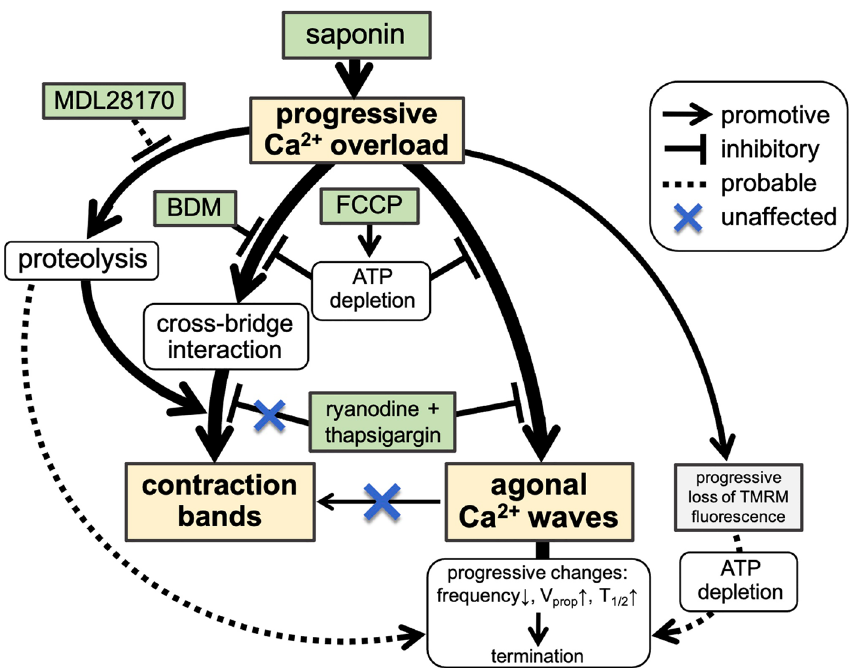
Figure 8. Schematic presentation of the saponin-induced generation of Ca 2+ waves and contraction bands with effects of various pharmacological